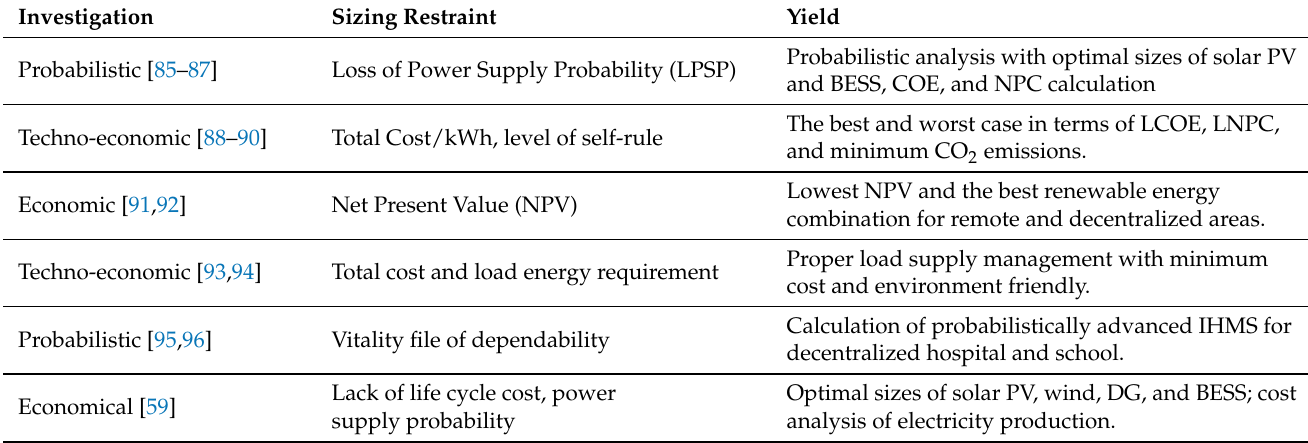
Table 3. Optimization and prediction of solar-wind IHMS [84].